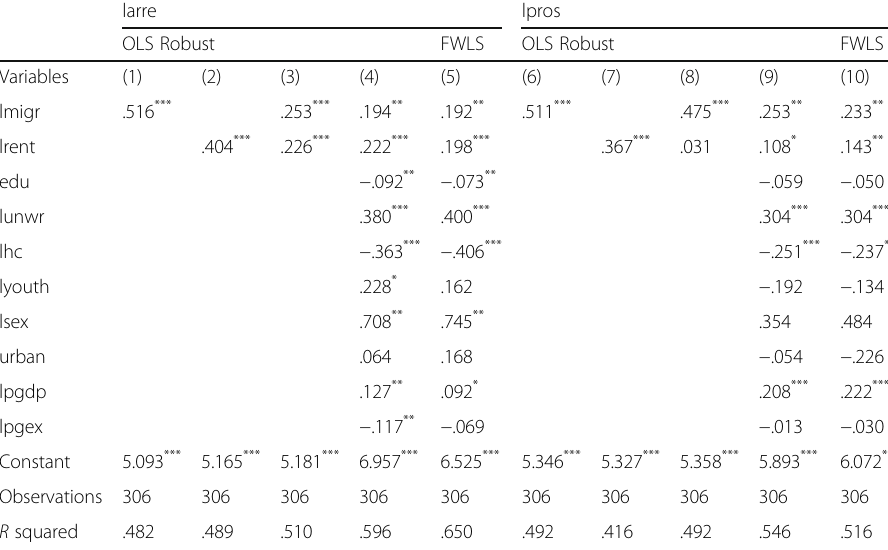
Table 3 Regression of influential factors for the crime rate: OLS Robust and FWLS larre lpros OLS Robust FWLS OLS Robust FWLS